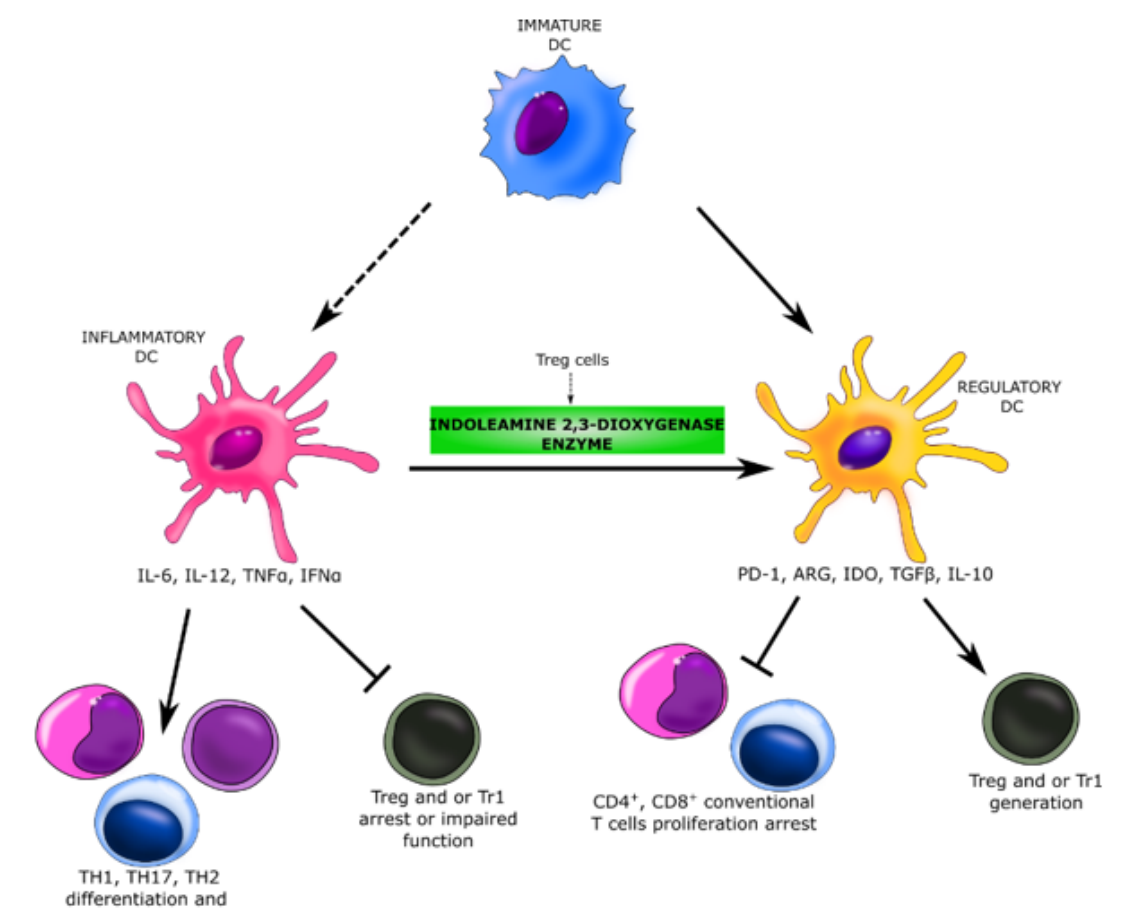
Figure 9. Suppression of the cytokine response in beekeepers. The repeated exposure to bee venom induces Treg cells, which impair the ability of allergen-specific T cells to proliferate and produce Th1 and Th2 cytokines. Treg cells induce indoleamine 2,3-dioxygenase enzyme in dendritic cells what causes the transformation of inflammatory dendritic cells into regulatory dendritic cells. These changes significantly suppress the cytokine response against the major bee venom allergen [16,55]. DC—dendritic cells; Treg—T regulatory cells; Tr1—type 1 regulatory cells; Th17—T helper 17 cells; PD-1—programmed